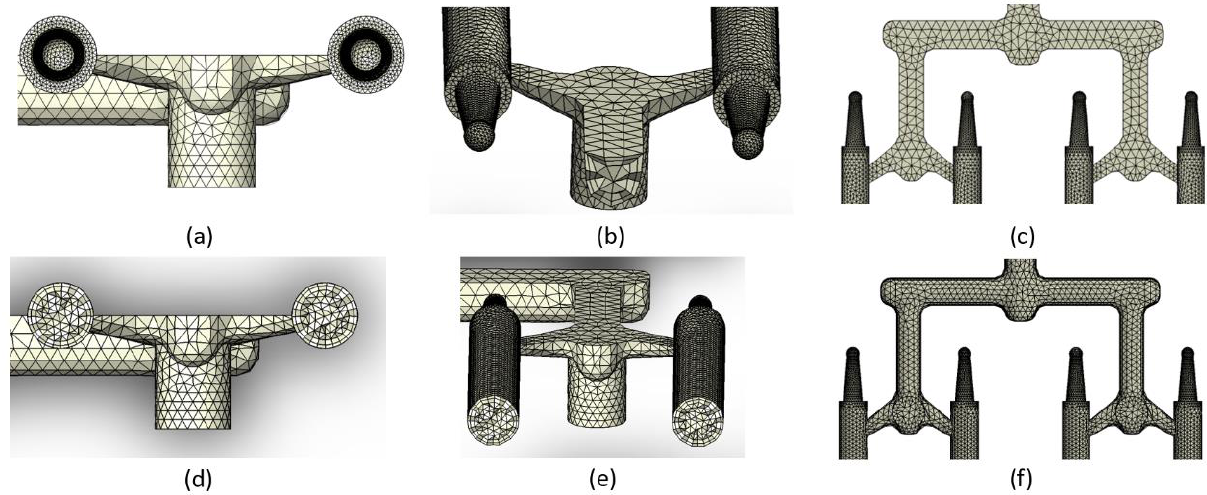
Figure 5. Three-dimensional (3D) mesh model of a stick: ( a ) front view of sticks; ( b ) back view of stick; and ( d , e ) clipping section (boundary layers are visible). Sticks and distribution runners: ( c ) view from above and ( f ) bottom view.